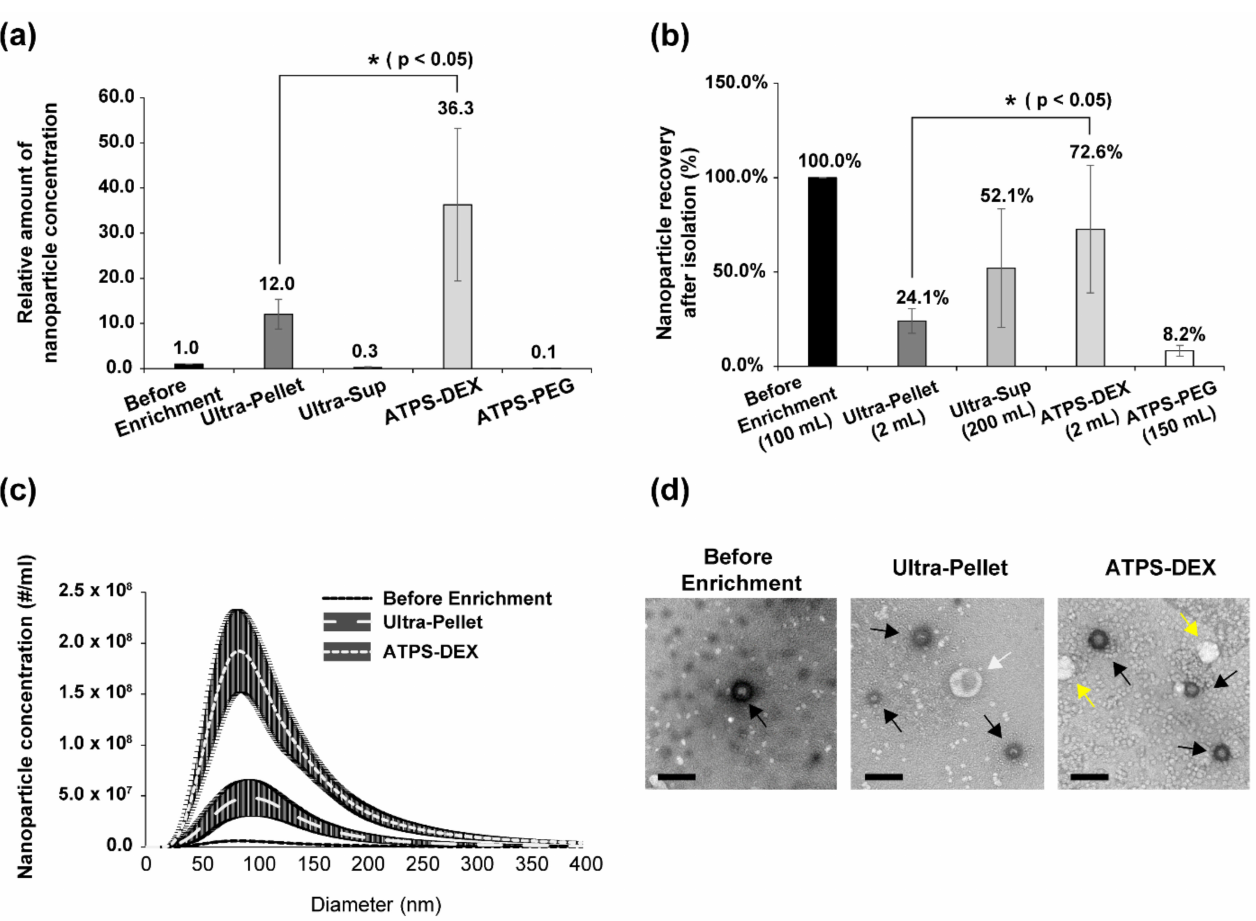
Figure 2. An analyses of nanoparticles enriched by ultracentrifugation and the aqueous two-phase system (ATPS). ( a ) The relative nanoparticle concentration was measured using nanoparticle tracking analysis (NTA). HCV (JC1-E2-Flag variant) particles were enriched by either ultracentrifugation or the ATPS. ( b ) Efficiencies of virus recovery were calculated using the concentration and volume of each fraction. ( c ) Size distribution of nano-sized particles was analyzed using NTA before and after enrichment. The concentration and size of nanoparticles were calculated by tracking the Brownian motion of particles. Experiments were performed three times with six times of particles tracking for each experiment. The shaded areas represent standard deviations. ( d ) Morphology of virus particles determined using transmission electron microscopy (TEM). HCV samples were negatively stained and observed using TEM. TEM revealed seeming HCV particles in spherical shapes. Black, white, and yellow arrows depict seeming HCV particles, extracellular vesicles, and lipoproteins (very-low-density lipoproteins), respectively (scale bar = 200 nm). The columns and bars in panels ( a , b ) represent the means and standard deviations, respectively. The average value is depicted on the top of each column. p values less than 0.05 are indicated by one asterisk (*). ATPS-DEX: ATPS dextran layer; ATPS-PEG: ATPS polyethylene glycol (PEG)